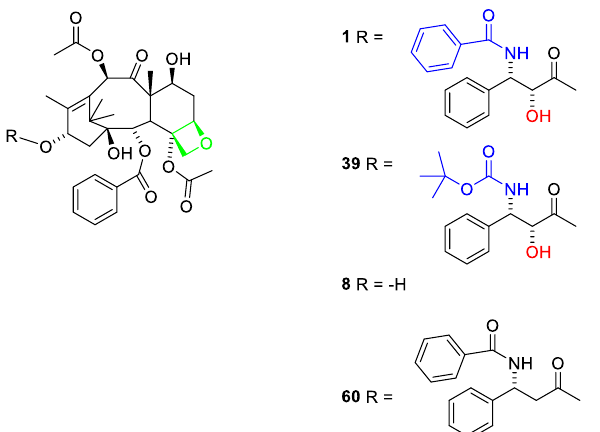
Figure 17. Structure activity relationships for the substituent at O-13. The hydroxy group at C- 2′ (red) is critical for affinity to microtubules. The C- 3′ acylamino group (blue) is important for the correct conformation of the diterpene nucleus [66,67].